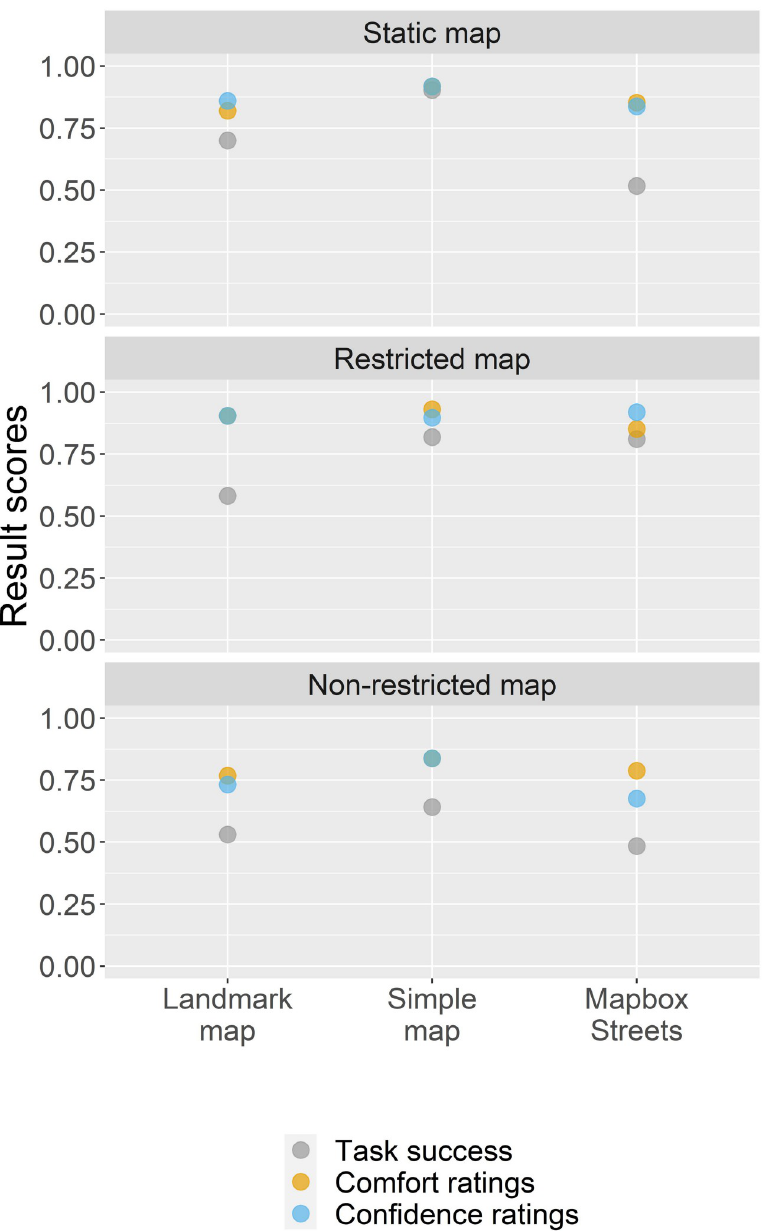
Fig 11. Task success, comfort, and confidence ratings of map design